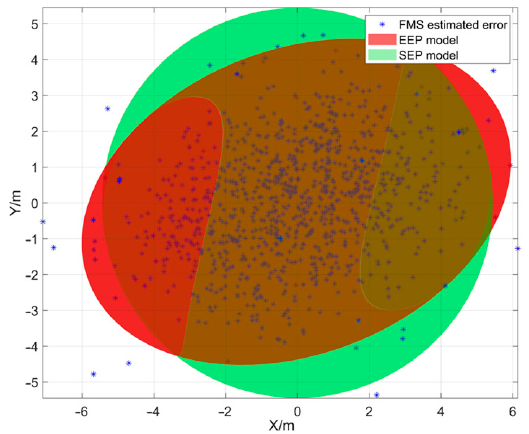
Figure 7. Comparison between EEP model and SEP model in XOY plane.